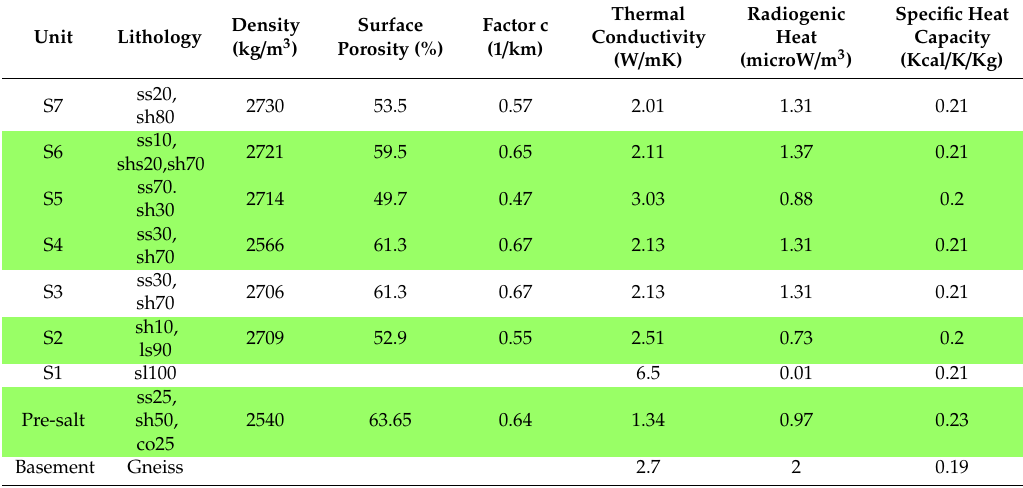
Table 1. Rock units and their parameter values for thermal modeling. For lithology definition, the percentage of sandstone (ss), siltstone (slt), shale (sh), limestone (ls), coal (co) and salt (sl) is defined. Source rock intervals are colored green. Values of thermal conductivity and heat capacity are given for each unit at 20 ◦